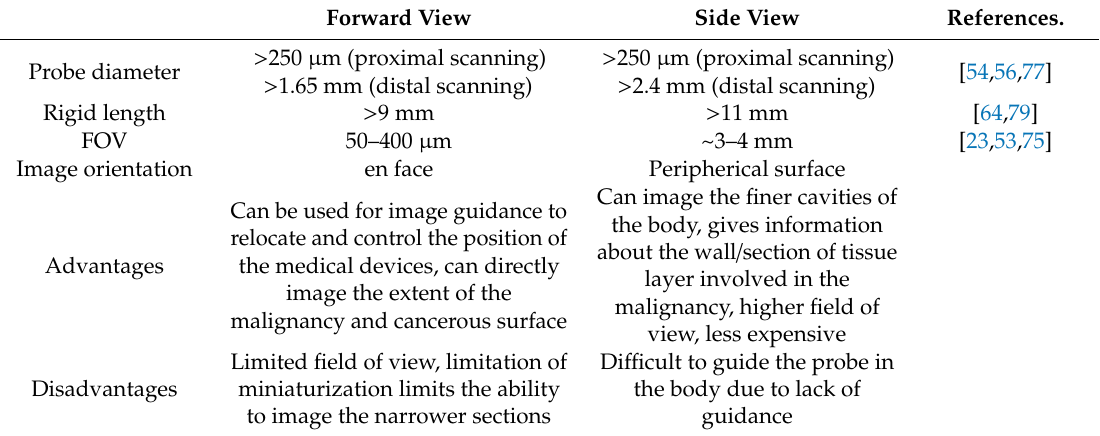
Table 2. Comparison between forward and side view